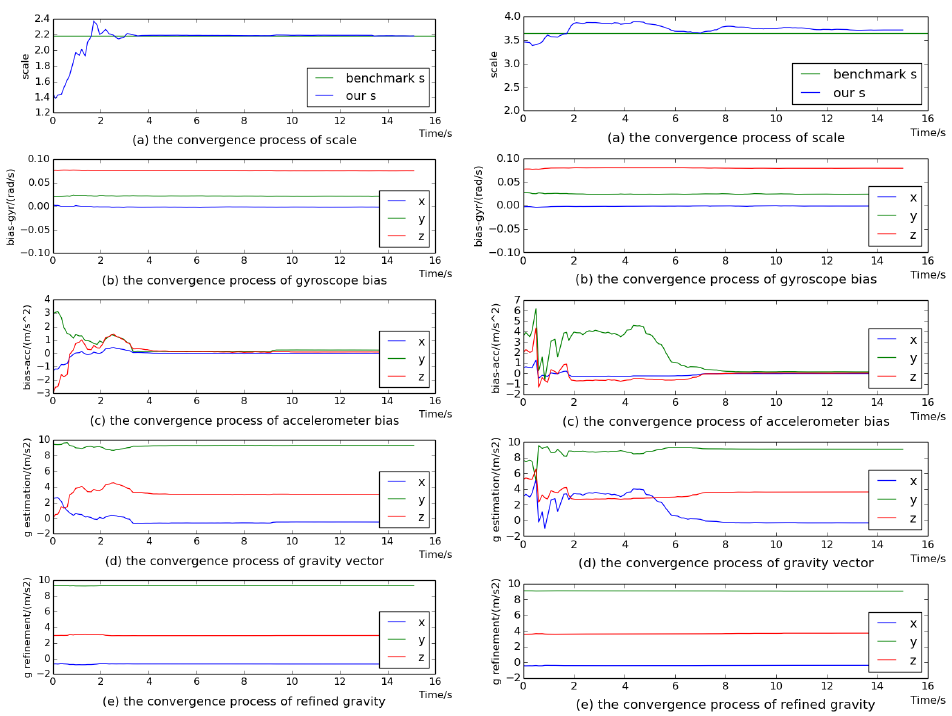
Figure 4. The convergence procedure of initial state on sequences V1_02_medium ( left ) and V2_02_medium ( right ).